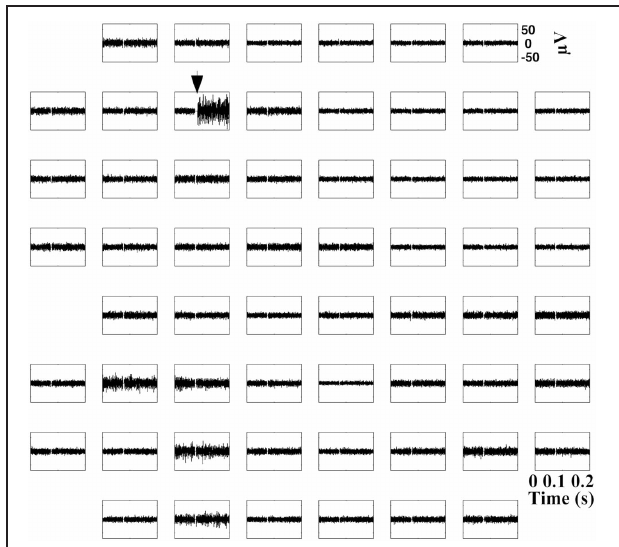
FIGURE 4 | Oscillations are isolated to a single electrode. 200ms of SALPA filtered traces appropriately oriented to each of 59 electrodes (200 μ m spacing) from a single microelectrode array. 0.5V stimulus occurs only on the electrode with the black arrow. Representative example (hippocampal culture age six weeks) from n = 152 electrodes in six cultures (two cortical and four hippocampal). TTX was not present in the medium.